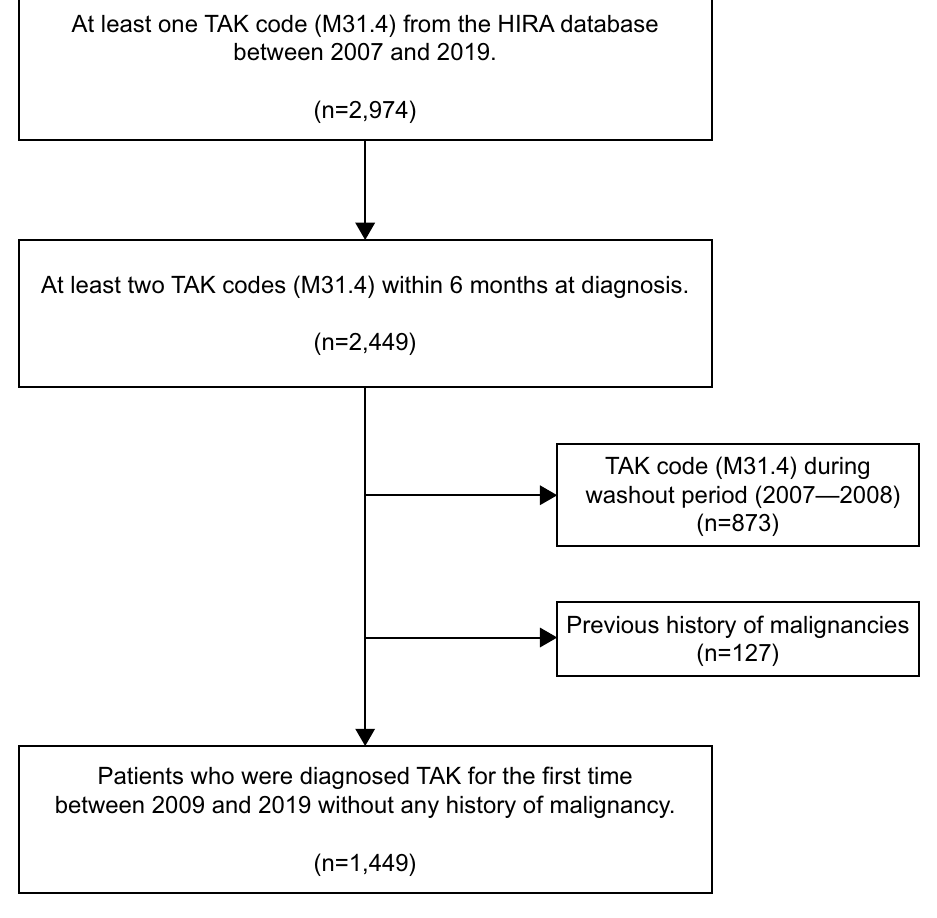
Figure 1. Flowchart of the selection process of included patients with Takayasu’s